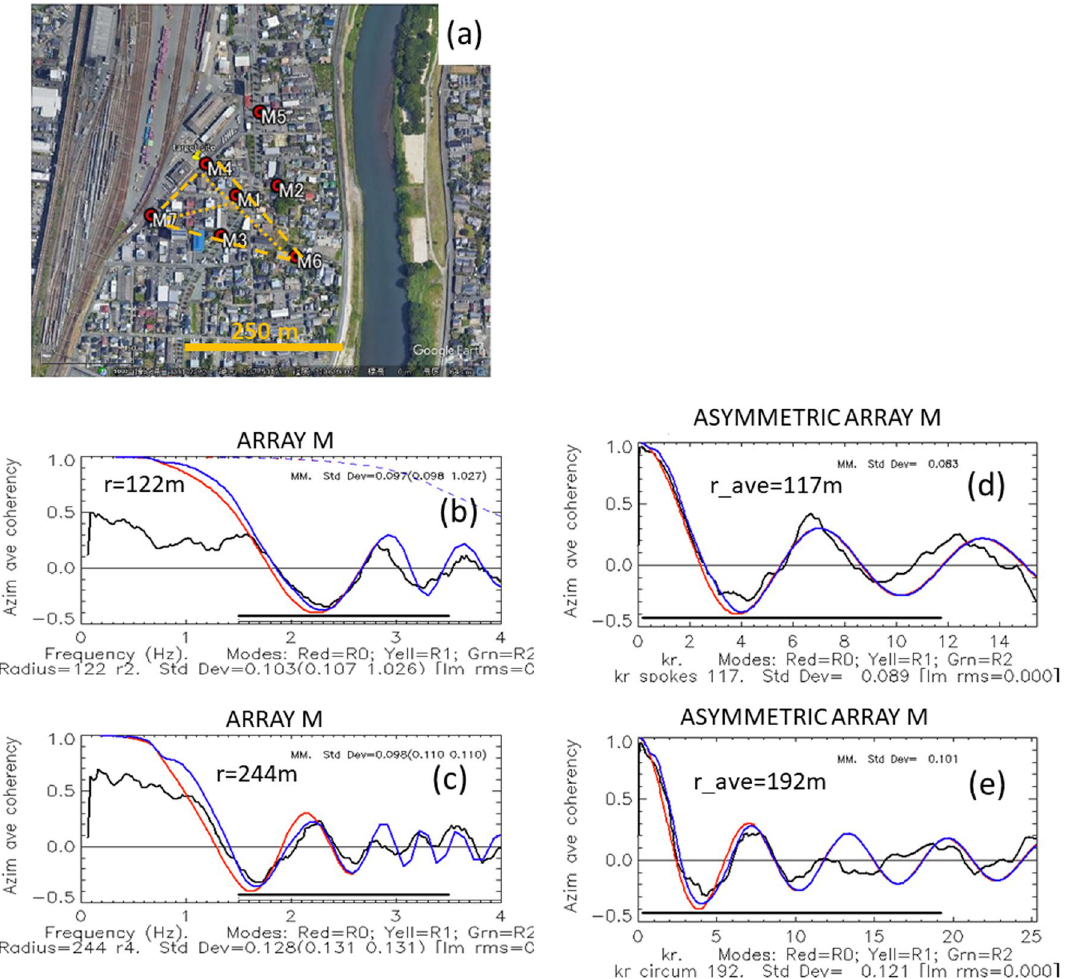
Fig. 2 a Locality for mid-size arrays in Kumamoto City, Japan. Dotted yellow lines—the “radii” of an asymmetric “triangle” centered on M1. Dashed yellow—sides of the asymmetric triangle. Red circles show a pair of nested triangles side lengths 122 and 244 m. Stations M2, M3, M5 are corrupted by low-frequency noise below1.5 Hz. Small arrays SM, S and SS1 (apertures 78, 20 and 2 m) are centered close to station M4. b , c SPAC spectra for the inner, outer triangles of array M, apertures 122, 244 m. Colors as for Fig. 1. Thick black line—the frequency range 1.5–3.5 Hz used in the curve fitting. d , e krSPAC spectra for the (unequal) radii and (unequal) sides (average lengths 117 and 192 m respectively) of the asymmetric traingle shown in ( a ). Thick black line—the kr range used in the curve fitting, equivalent to an extended frequency range 0.5–3.5